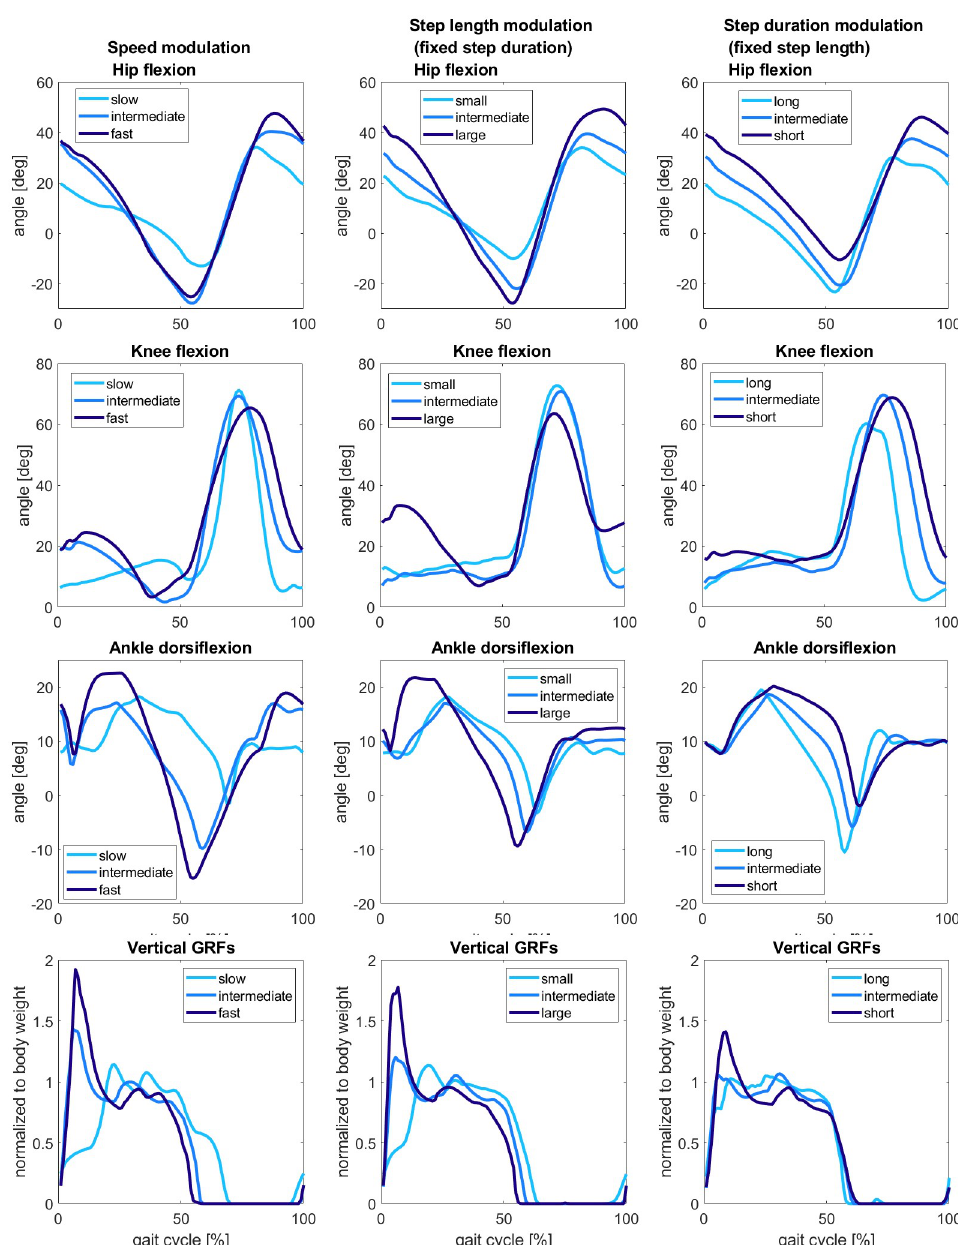
Fig 7. Joints angles and ground reaction forces for low, intermediate, and high values of the three gait characteristics. The cyan curves describe the slow gaits with small step lengths and long step durations, whereas the dark blue curves describe the fast gaits with large step lengths and short step durations. The change observed in speed modulation is closer to the only step length modulation than the modulation of step duration.